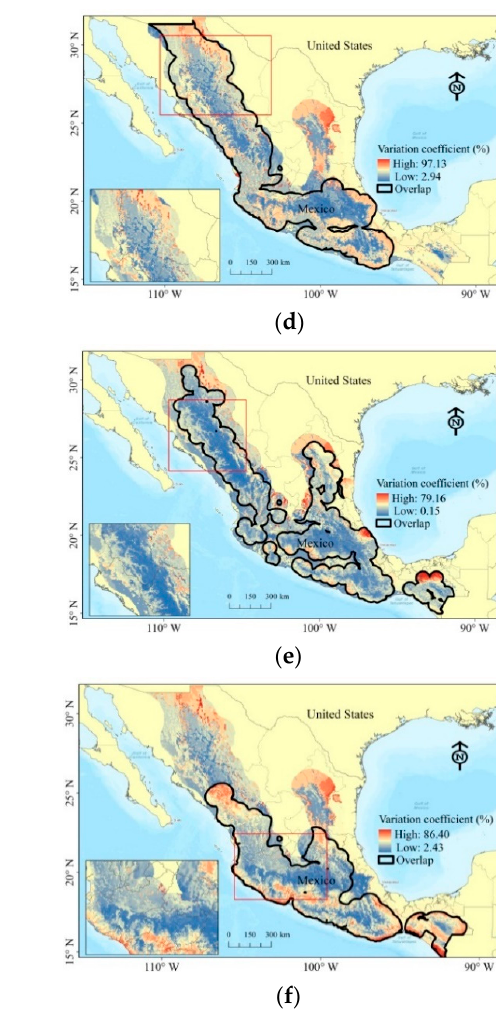
Figure 4. Suitable areas free of the bark beetle for: ( a ) Pinus leiophylla (orange color), ( b ) Pinus teocote (blue color), and ( c ) Pinus devoniana (green color), suitable areas free of the bark beetle Dendroctonus mexicanus . Average uncertainty, expressed as variation coefficient of the prediction model of each pine species ( d – f ), respectively. The continuous line is the bark beetle calibration area; dotted line and shaded area is the pine species calibration area.